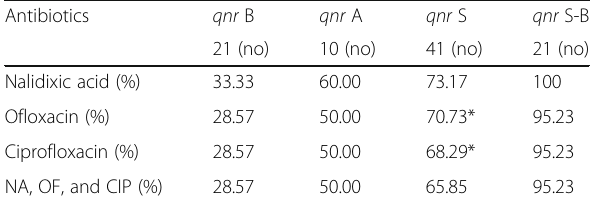
Table 4 Percentage of resisting isolates to nalidixic acid, ofloxacin, and ciprofloxacin, among strains which have harbored just one type of qnr genes and/or qnr S and